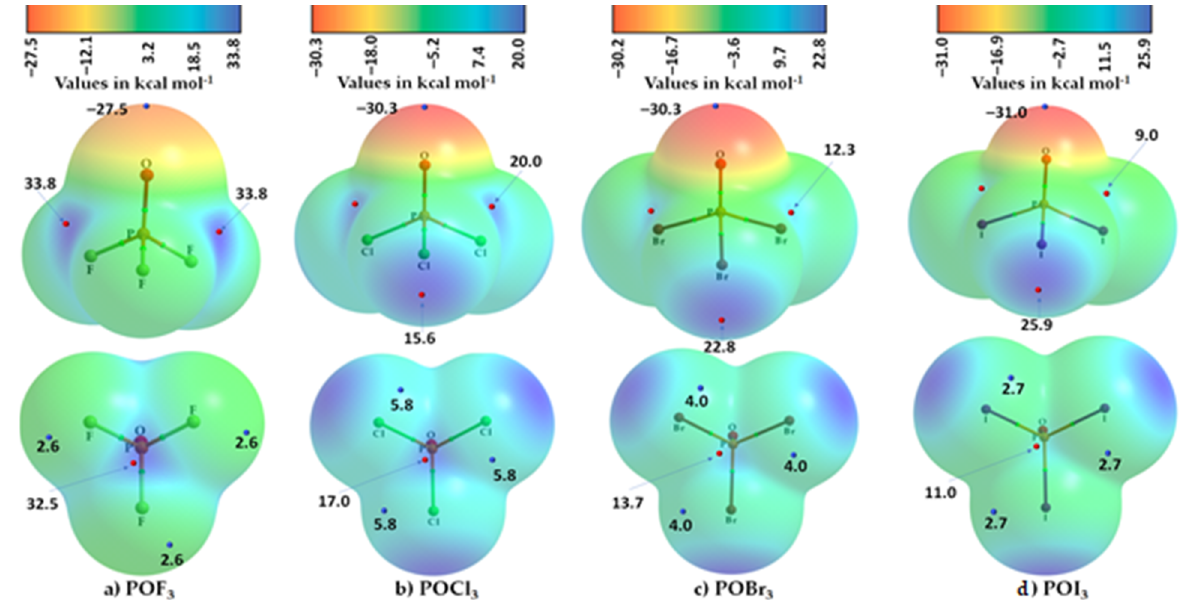
Figure 9. MP2(full)/def2-TZVPPD level molecular electrostatic surface potential plot of POX 3 (X = ( a ) F, ( b ) Cl, ( c ) Br, ( d ) I) molecules. The geometry of each molecule was optimized at the same level of theory. The 0.001 a.u. isodensity envelope was used to compute the electrostatic potential. The tiny circles in red and blue represent V S,max and V S,min , respectively, with values in kcal mol − 1 . The QTAIM-based molecular graphs are superimposed for each case, and the bond paths are in atom color, accompanied by bond critical points (tiny spheres in green between bonded atomic basins). The atom type is shown. (Top) The halogen atom in POX 3 faces the reader. (Bottom) The phosphorus atom in POX 3 faces the reader.